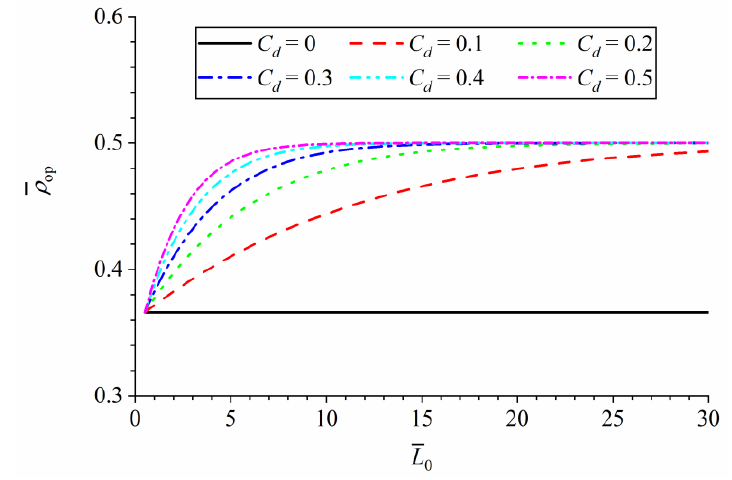
Figure 20. The relationship between ρ